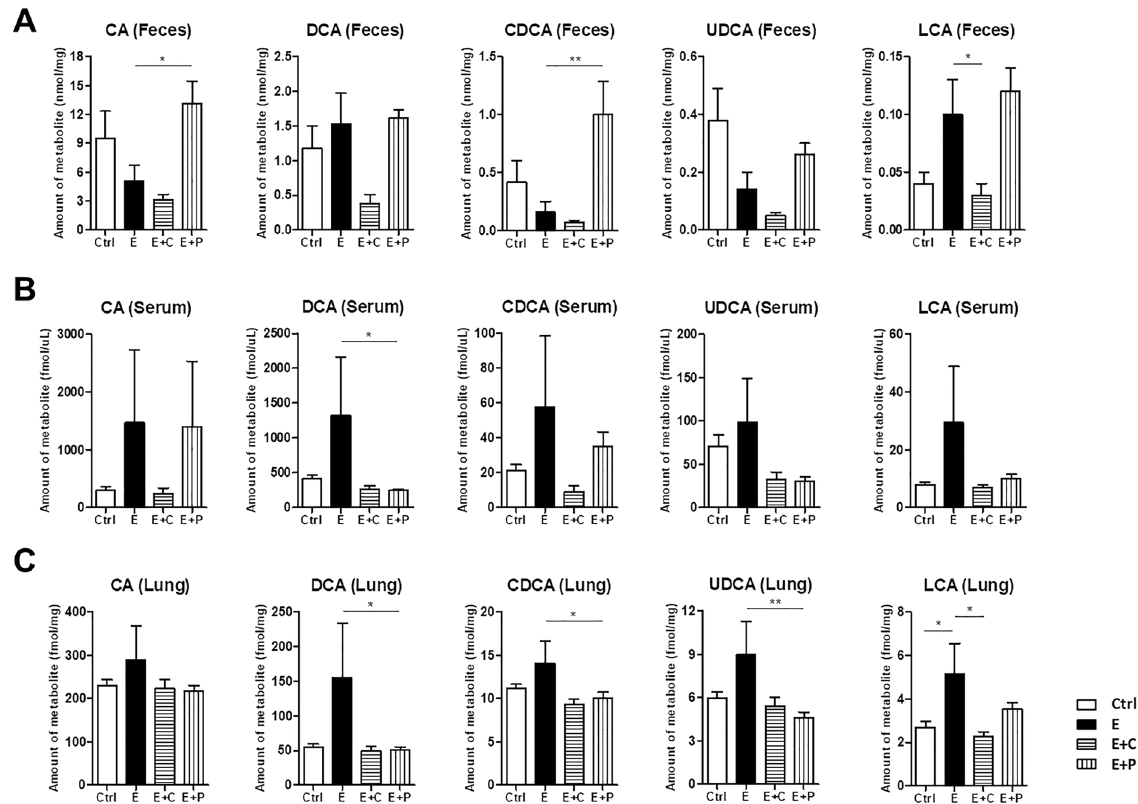
Figure 6. Dietary fiber alters the bile acid (BA) metabolism. ( A – C ) The levels of the BA metabolites (CA, DCA, CDCA, UDCA, and LCA) in the feces ( A ), serum ( B ), and lung ( C ) were measured using metabolite profiling. (n = 6 mice per group). Values are expressed as the mean ± SE. * P < 0.05 and ** P < 0.01. Ctrl control group, E emphysema group, E + C emphysema with high-cellulose diet group, E + P , emphysema with high-pectin diet group, CA cholic acid, DCA deoxycholic acid, CDCA chenodexycholic acid, UDCA ursodeoxycholic acid, LCA lithocholic